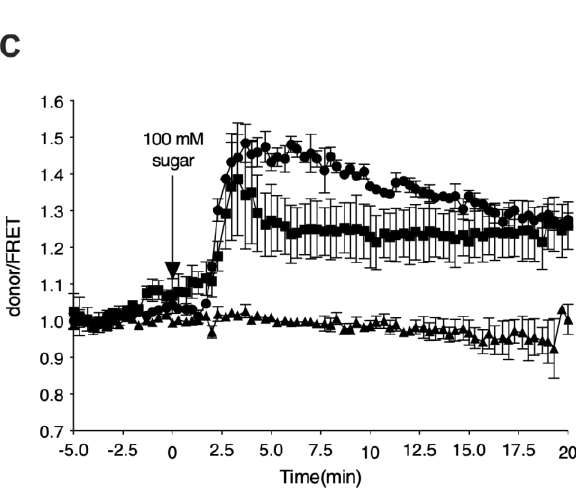
FIGURE 1: Glucose activates trehalase in a Gpr1 receptor and cAMP-dependent manner. (A) Activation of the PKA target treha- lase after addition of 100 mM glucose to glycerol grown, glucose derepressed cells. Strains: wild type (closed circles) and gpr1 ∆ (open circles). (B) Donor/FRET levels for cAMP determination in vivo upon addition of glucose to glycerol grown cells. Strains: wild type (closed circles) and gpr1 ∆ (open circles). Mean values of at least three bio- logical replicates, normalised to the value before glucose addition (0 min), are shown with the standard error of the mean. (C) Do- nor/FRET levels for cAMP determination in vivo upon addition of 100 mM sugar to glycerol grown wild type cells. Sugars: glucose (circles), sucrose (squares) and fructose